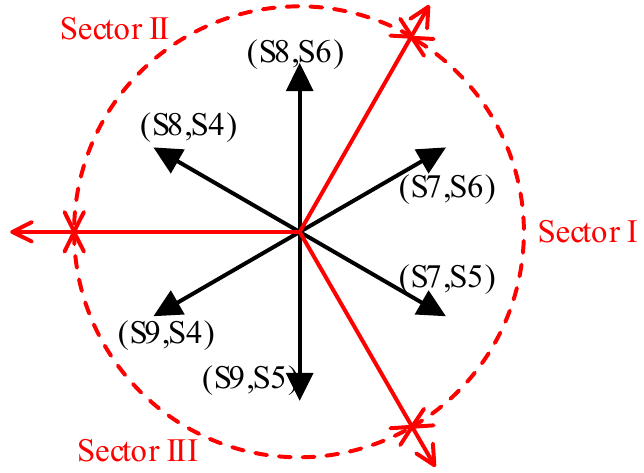
Figure 5. Switching sequence in the inverter side. The overall diagram of the proposed modulation strategy for the nine-switch